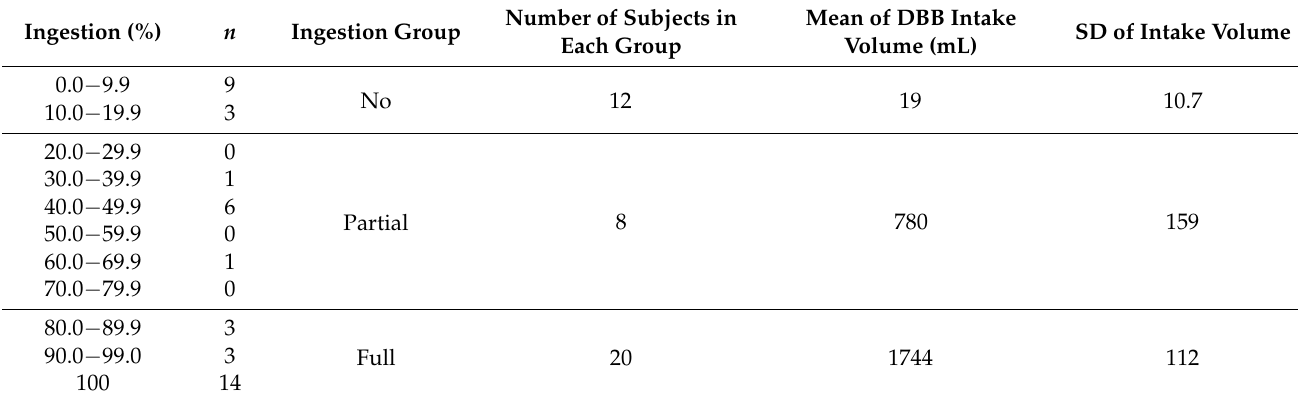
Table 3. DBB ingestion volume and intervention categories in children in Thanh Khe (DBB-intervention area).